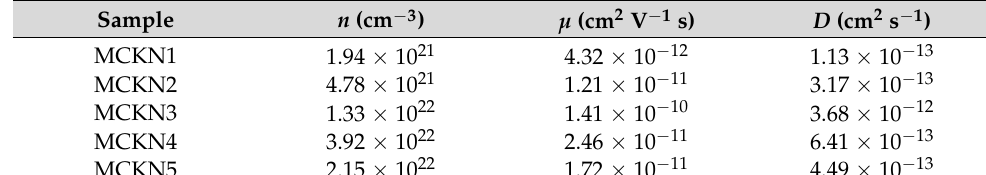
Table 3. The values of D , µ , and n at room temperature using FTIR method.